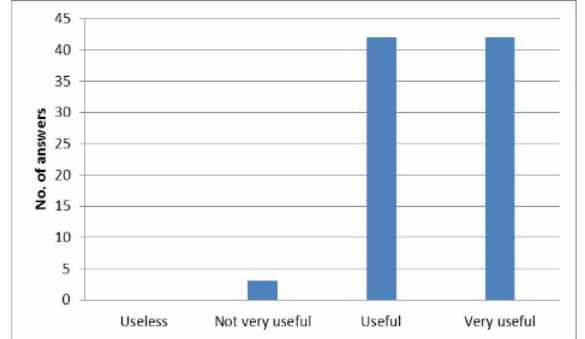
Figure 7. Results of Question